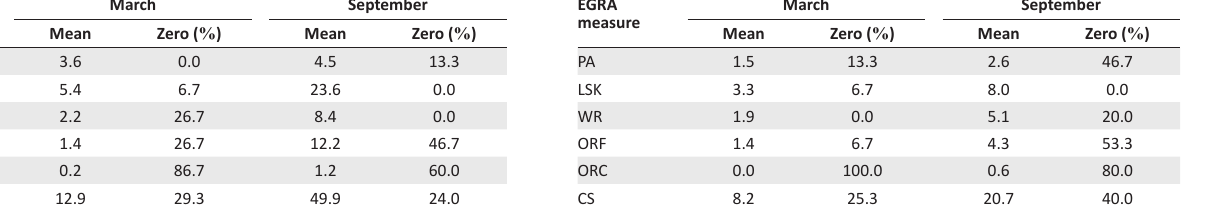
TABLE 5: Descriptive statistics for T2 classroom in school B. EGRA measure